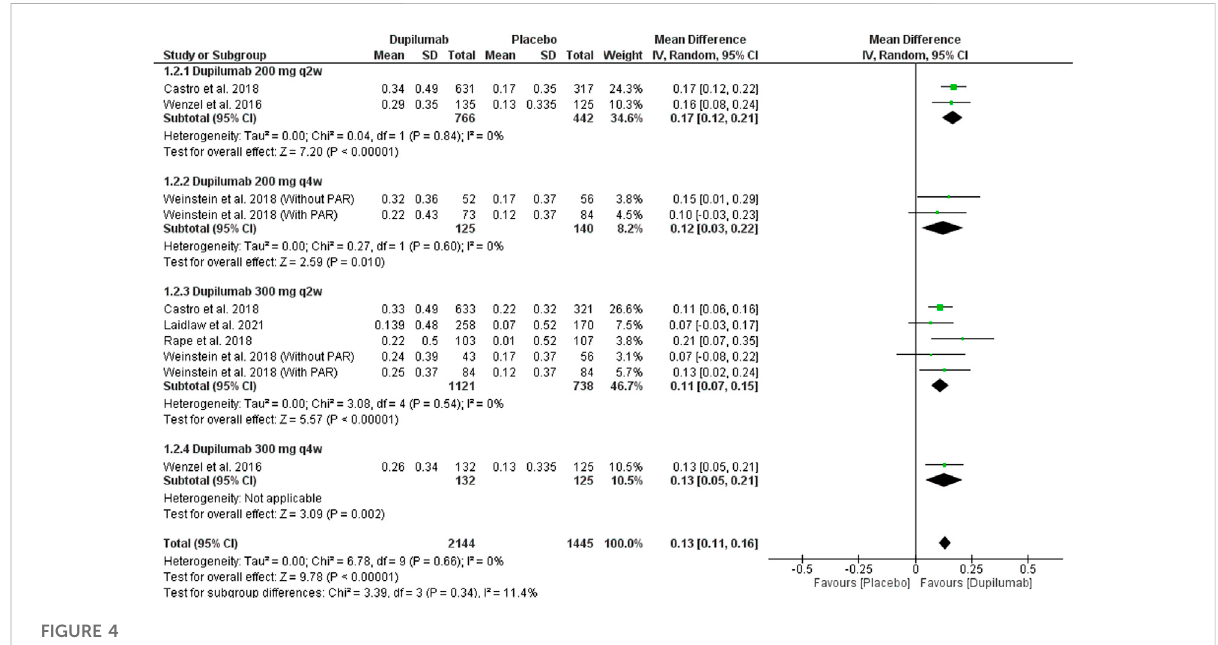
FIGURE 4 Results of the FEV1 change at the 24th week.